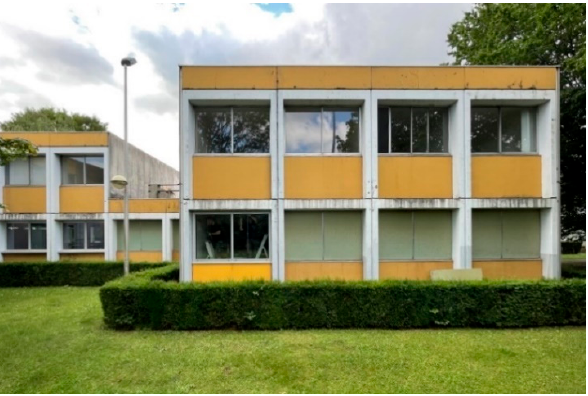
Figure 7. Case study 2: WVDM Living Lab, renovation student housing buildings Vrije Universiteit Brussel, Brussels (Belgium). Source: MAKER Architecten [57].